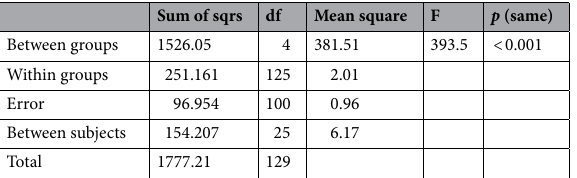
Table 3. ANOVA of velocities during the three different phases (V1, V2,